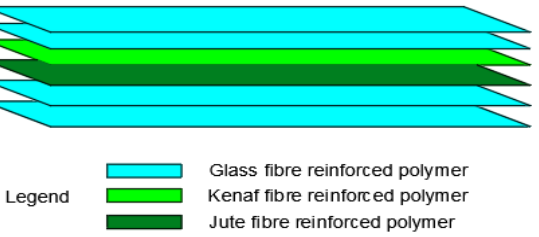
Figure 10. Stacking sequence of optimal hybrid FRP in flexure, incorporating natural fibres with overall thickness of 2.3 mm [46].